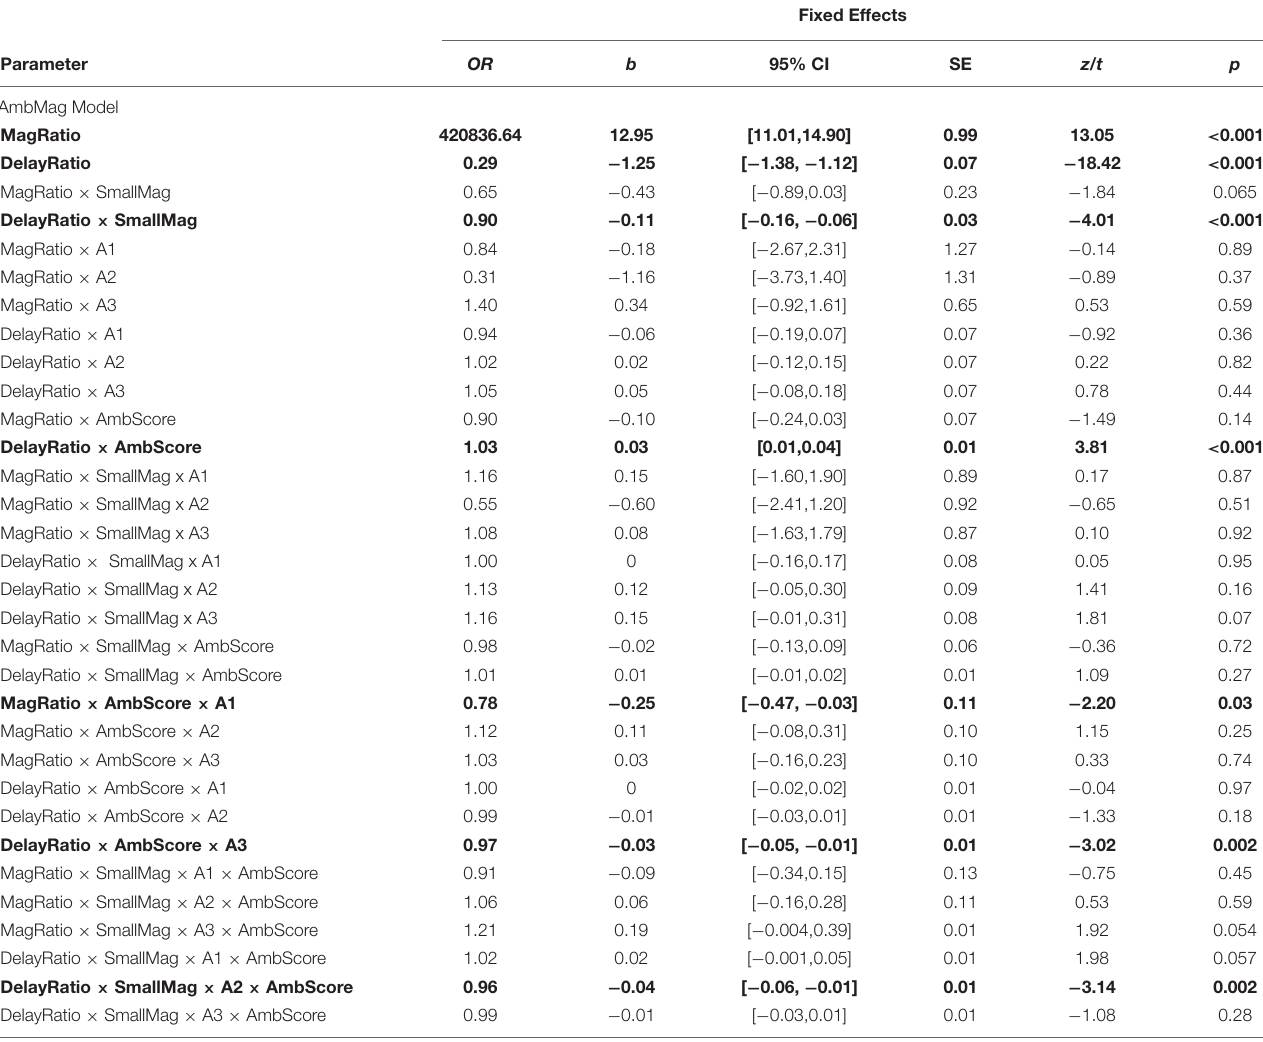
TABLE 3 | Parameter estimates of the logistic mixed model of ambivalence and sensitivities to delay and magnitude